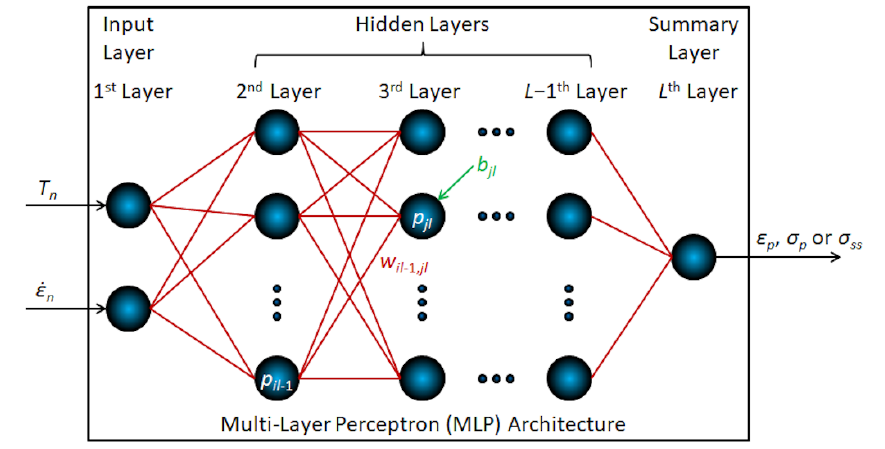
Figure 2. General architecture of the utilized multi-layer perceptron networks. The blue-black spheres—artificial neurons (perceptrons); The red lines—synaptic connections.